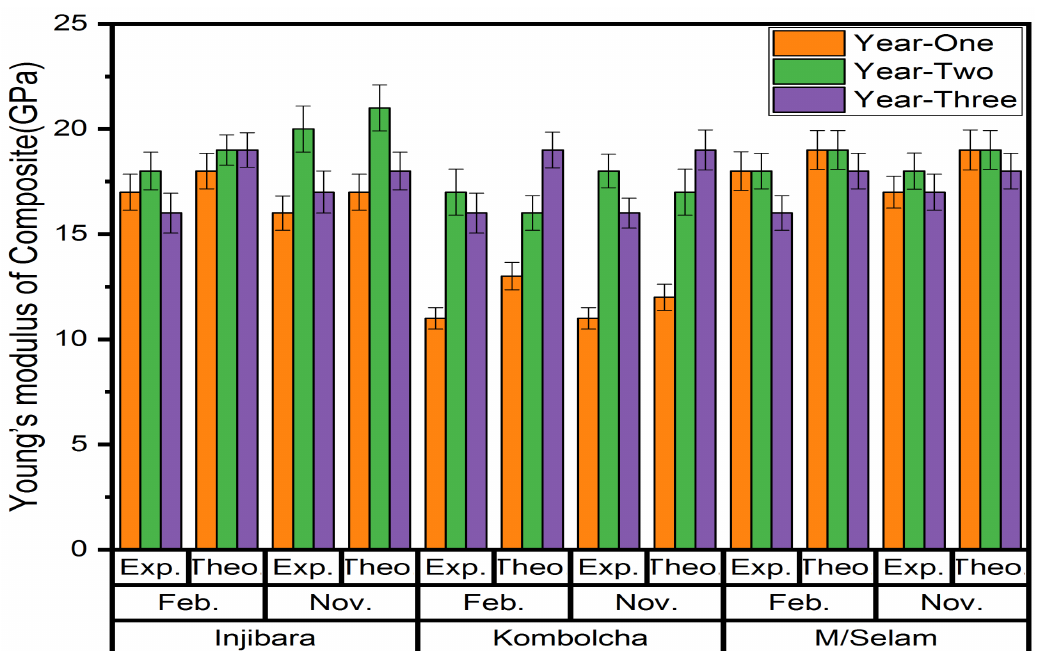
Figure 8. The experimental and theoretical values of Young’s moduli of the